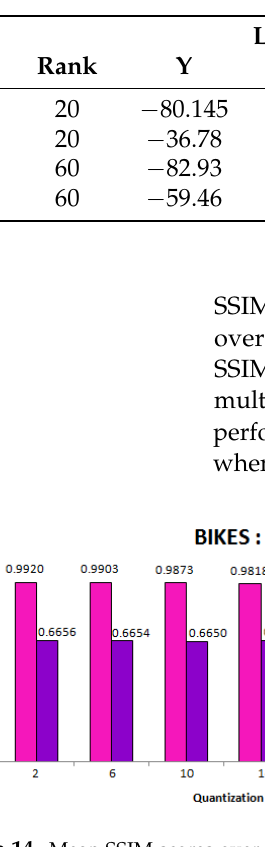
Figure 14. Mean SSIM scores over each QP of decoded views in BLOCK III of proposed scheme with (ML(3)) and without (AV(169)) multiplicative layers. Experiment evaluated on Bikes light field for BK-SVD ranks 20 and